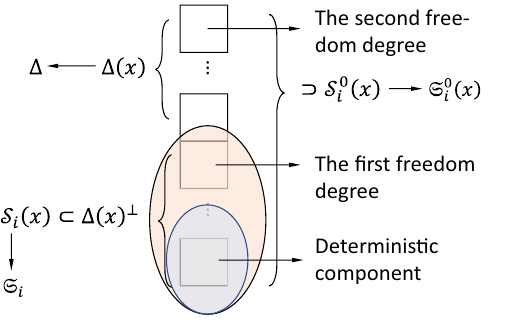
Figure 2. Relationship